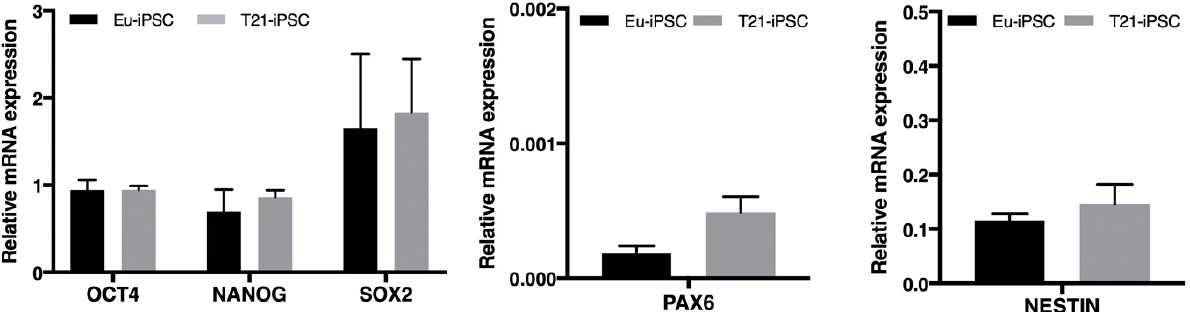
Figure 2. mRNA expression of stemness and differentiation marker genes in euploid and trisomic iPSC clones. Expression of the pluripotency markers, OCT4 , NANOG and SOX2 , and the neural differentiation markers, PAX6 and NESTIN , was evaluated by qRT-PCR. Pluripotency markers are detected in all iPSCs without significant differences among clones. NESTIN and PAX6 are expressed at very low level in euploid and trisomic iPSCs. mRNA expression levels are normalized to a reference gene ( ACTIN ). Results are expressed as mean values ± SEM of at least four independent experiments for each cell line. T21-iPSC values represent the average of the two trisomic clones used.